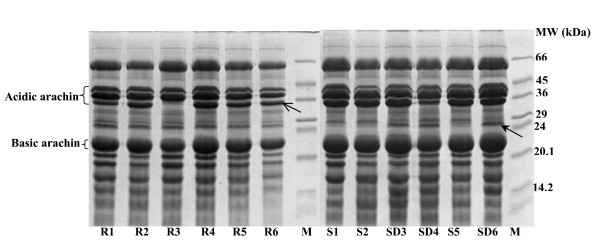
SDS-PAGE peanut seed total protein profiles. One-dimensional SDS-PAGE of peanut seed protein of runner (R) and Spanish (S) or Spanish derivatives (SD): R1 = A104, R2 = GK 7, R3 = A13, R4 = Tifrunner, R5 = A100, R6 = Georgia Green; S1 = ICGV 95435, S2 = MXHY, SD3 = GT-YY7, SD4 = GT-YY79, S5 = ZQ 48, SD6 = GT-YY20; M = molecular weight standards. The arrow () indicates the protein band with a molecular weight of 35 kDa and the arrow () indicates the 26 kDa protein band.